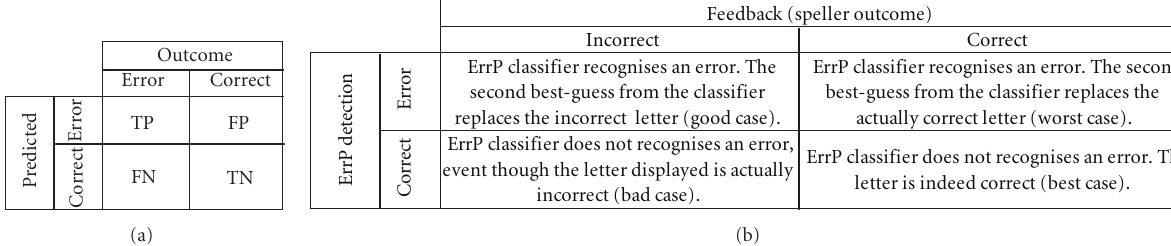
Figure 3: Confusion matrix for a general binary problem (a) and in the context of error correction (b), adapted from [14]. TP: true